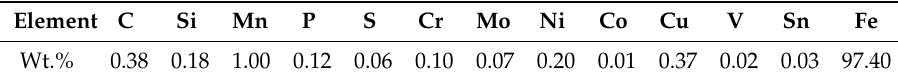
Table 4. Chemical composition of the steel bars.